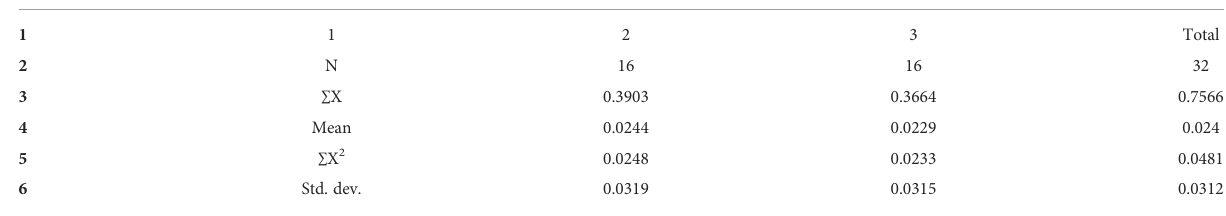
TABLE 2 ANOVA test